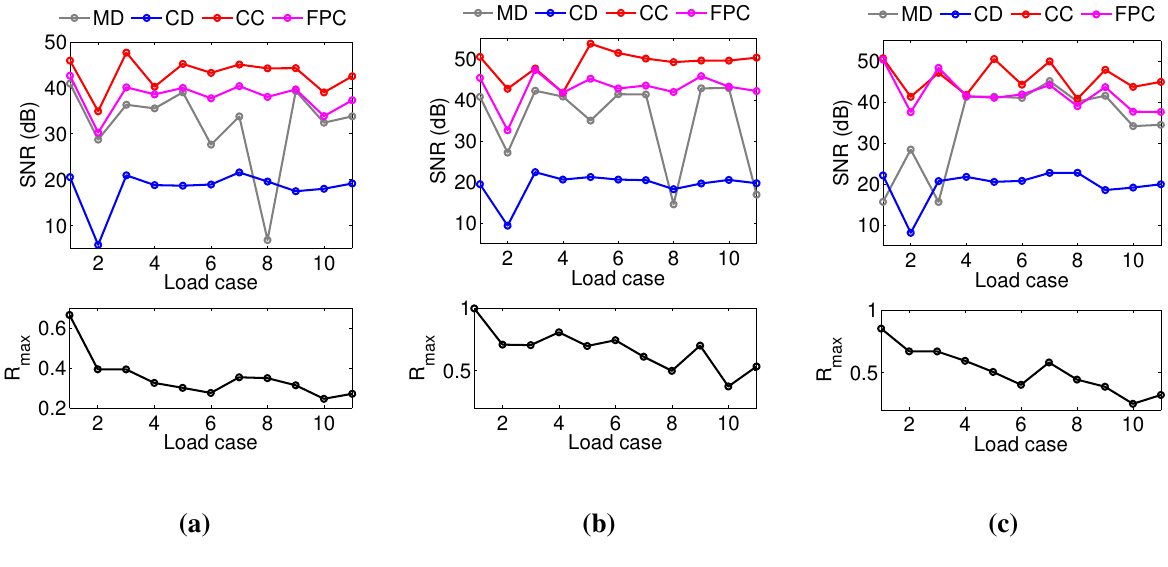
Figure 13. SNR levels ( top ) and maximum reflectivities ( bottom ) variations as a function of the load case. ( a ) FBG1; ( b ) FBG2; ( c )